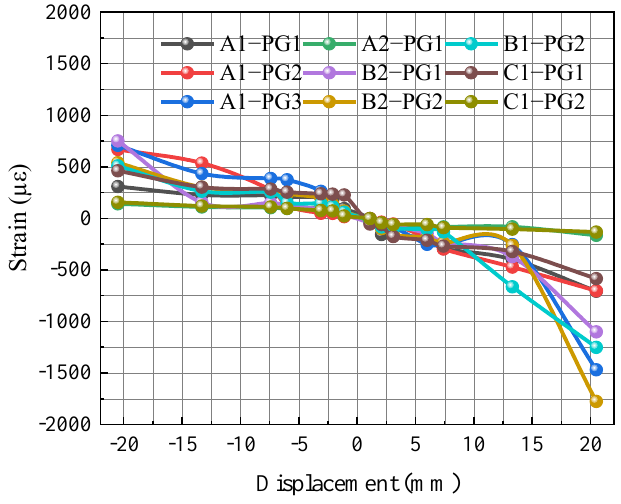
Figure 20. Strain of stirrups in thick plates.